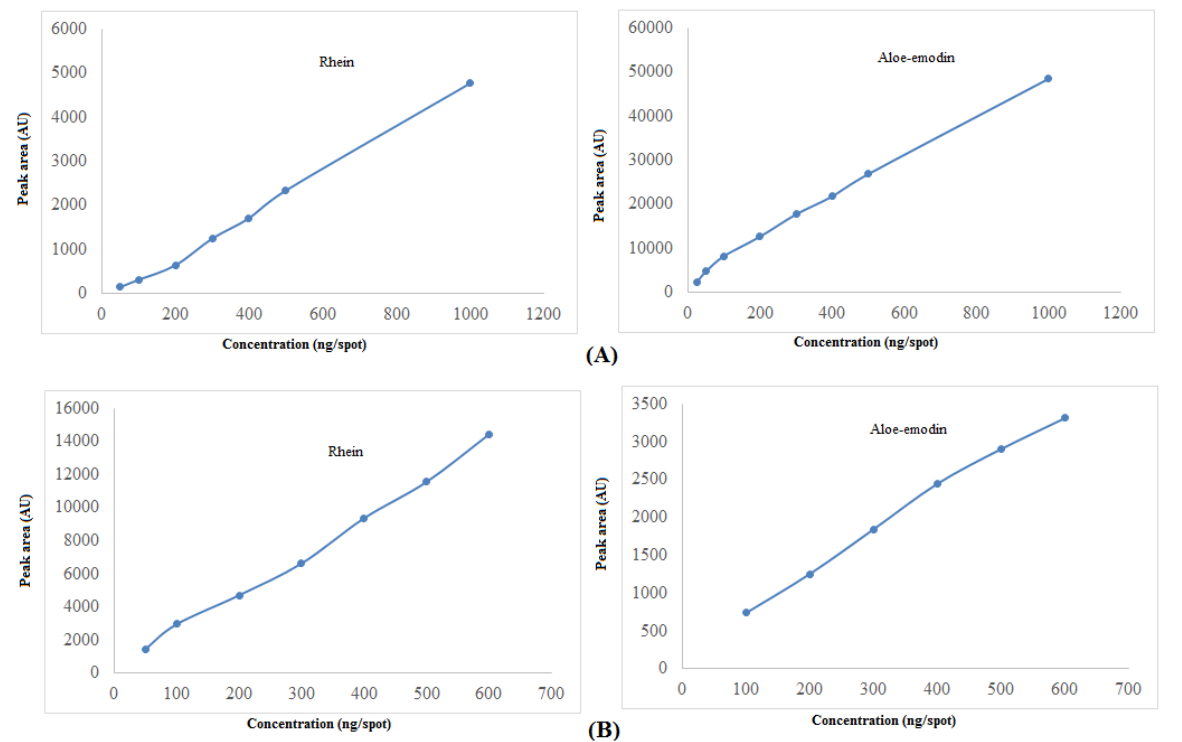
Figure 4. Representative calibration curves of standard rhein and aloe-emodin obtained using ( A ) sustainable reverse-phase HPTLC and ( B ) conventional normal-phase HPTLC